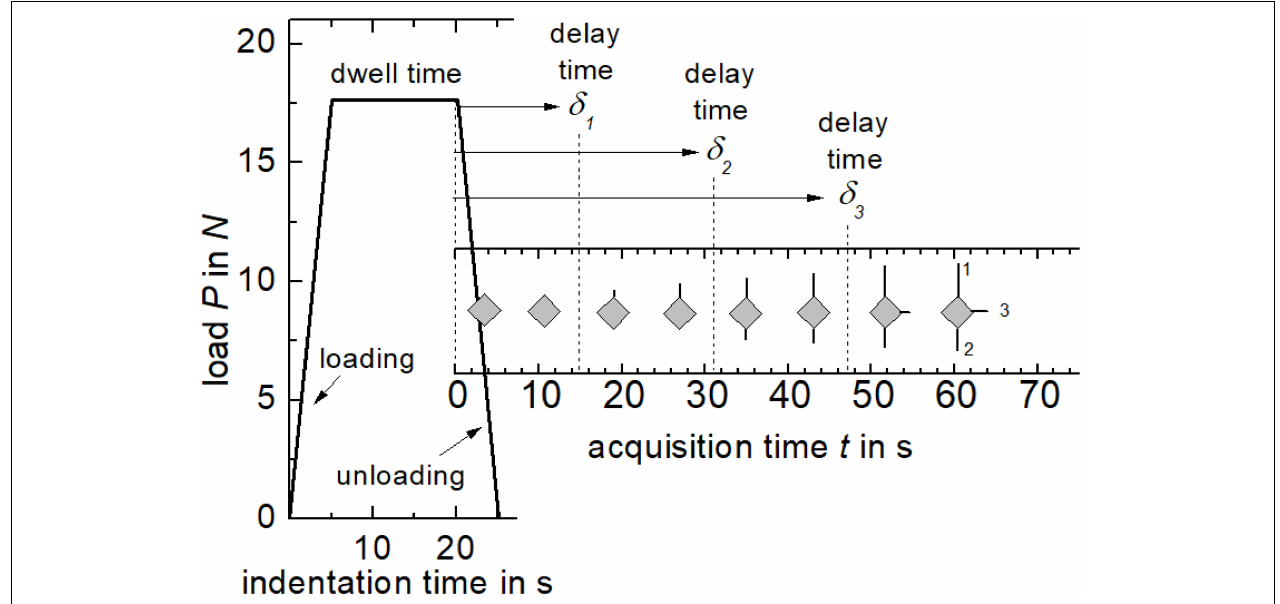
FIGURE 1 | Scheme of the load-time curve of the Vickers indentation. Automated image acquisition was triggered at the start of the unloading ramp. Radial cracks at the corner of the indent were observed to grow after a delay time δ .